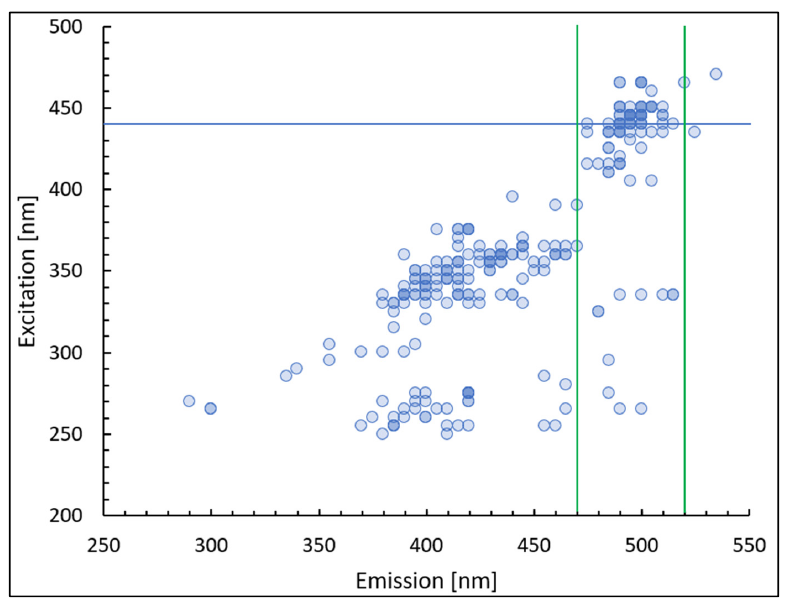
Figure 2. The fluorescing emission maxima wavelength as a function of excitation wavelength is shown for a variety of sulfuric acid mixtures with organic compounds. Each marker represents fluorescence intensity maximum yielded from one reaction conditions. The darkness of the marker indicates the number of instances with overlapping fluorescence peak maxima. The blue horizontal line represents the 440 nm excitation band of the blue Autofluorescence Nephelometer (AFN) laser and the green lines demarcate the range of possible wavelengths where the organic might emit fluorescence (in a cyan to green spectrum).